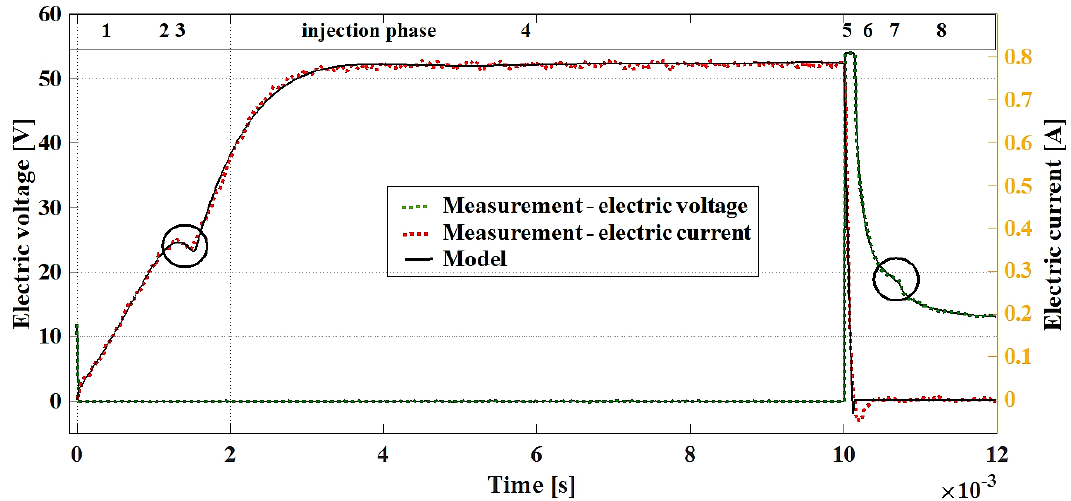
Figure 8. Measured and modeled electric current and voltage waveforms.